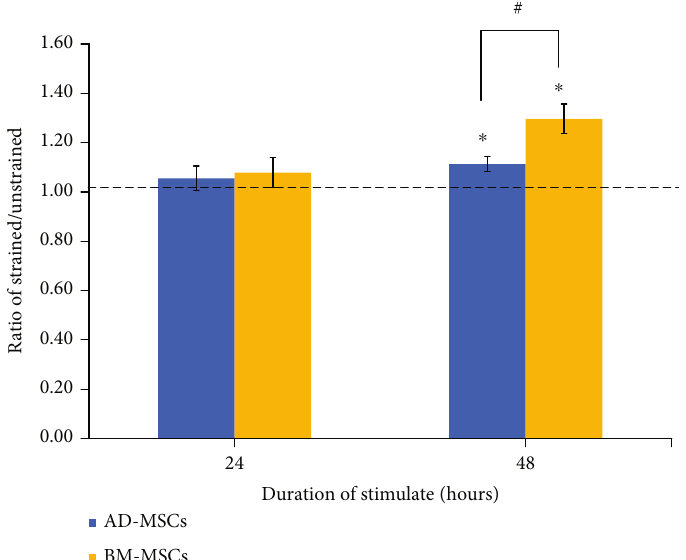
Figure 6: Extracellular collagen content analysis of AD-MSCs and BM-MSCs cultured at 1 Hz+8% at di ff erent duration of stretching. Statistical signi fi cance ( p < 0 : 05 ) was represented by an asterisk ( ∗ ) which was compared to the unstrained cells represented by the Y axis (indicated as 1.00). Statistical signi fi cance ( p < 0 : 05 ) was also represented by a hash (#) which is a comparison between AD-MSCs and BM-MSCs. N = 4 , n = 3 . Error bar = ±SD